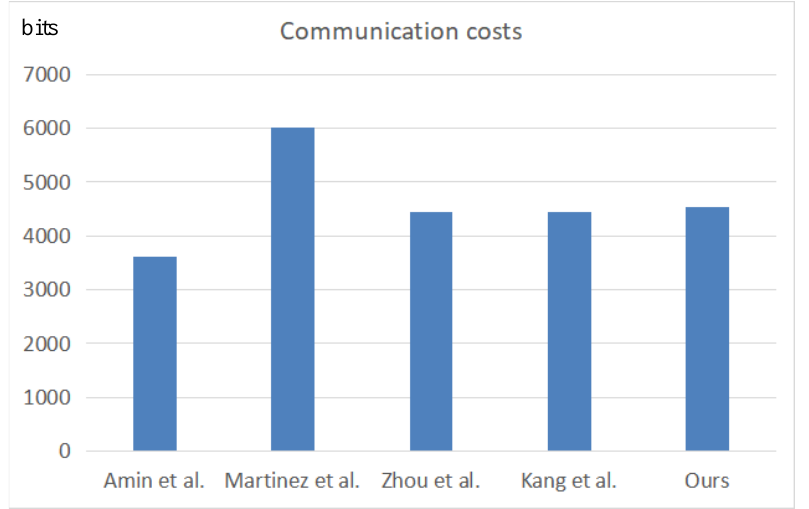
Figure 10. Comparative results of communication costs [13,17–19]. Table 7. Comparisons in terms of communication and storage costs.